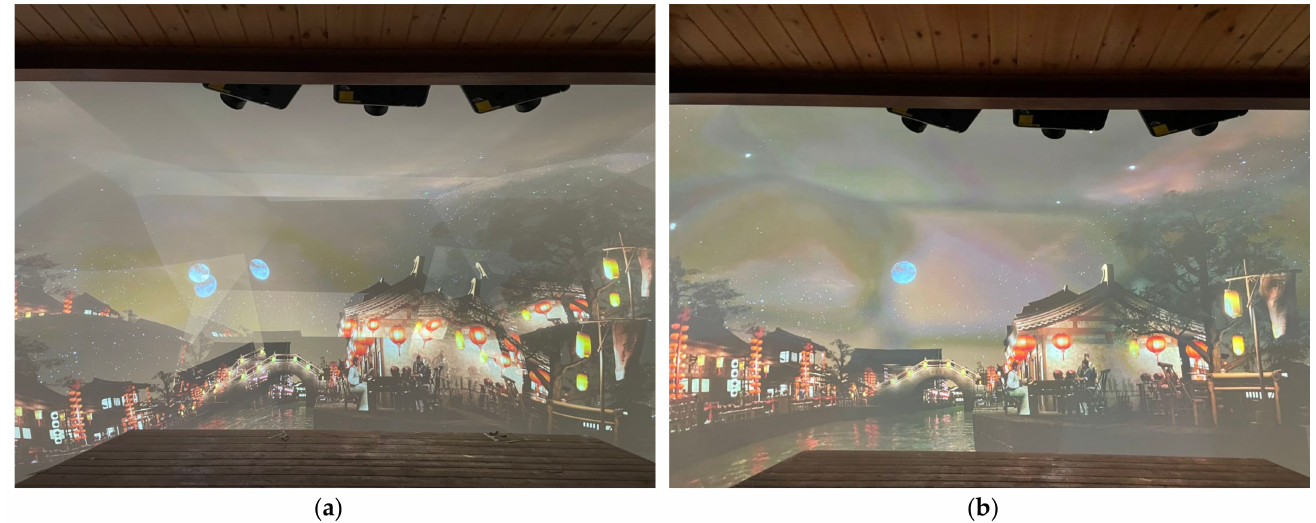
Figure 17. Contrast in a capsule-type projection system: ( a ) before geometric correction and ( b ) after geometric